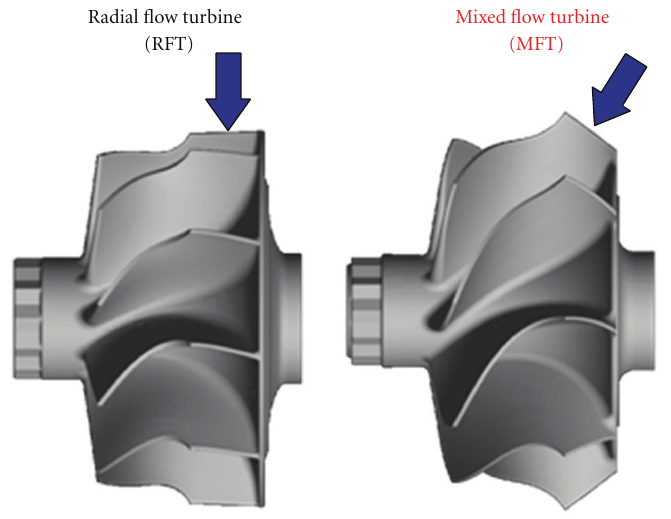
Figure 2: Radial versus mixed flow turbine.